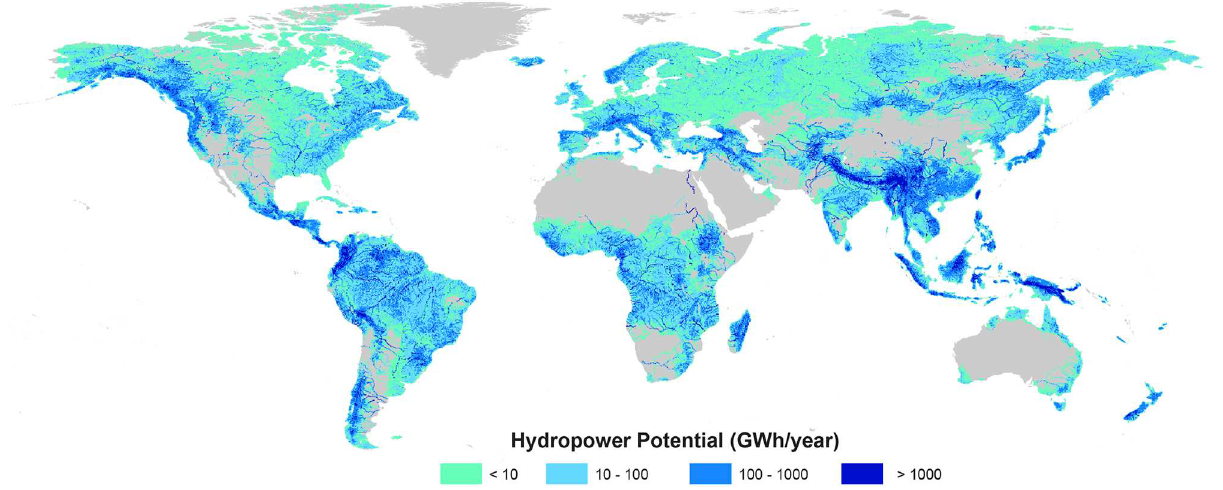
Fig 1. Global map of gross hydropower potential distribution.